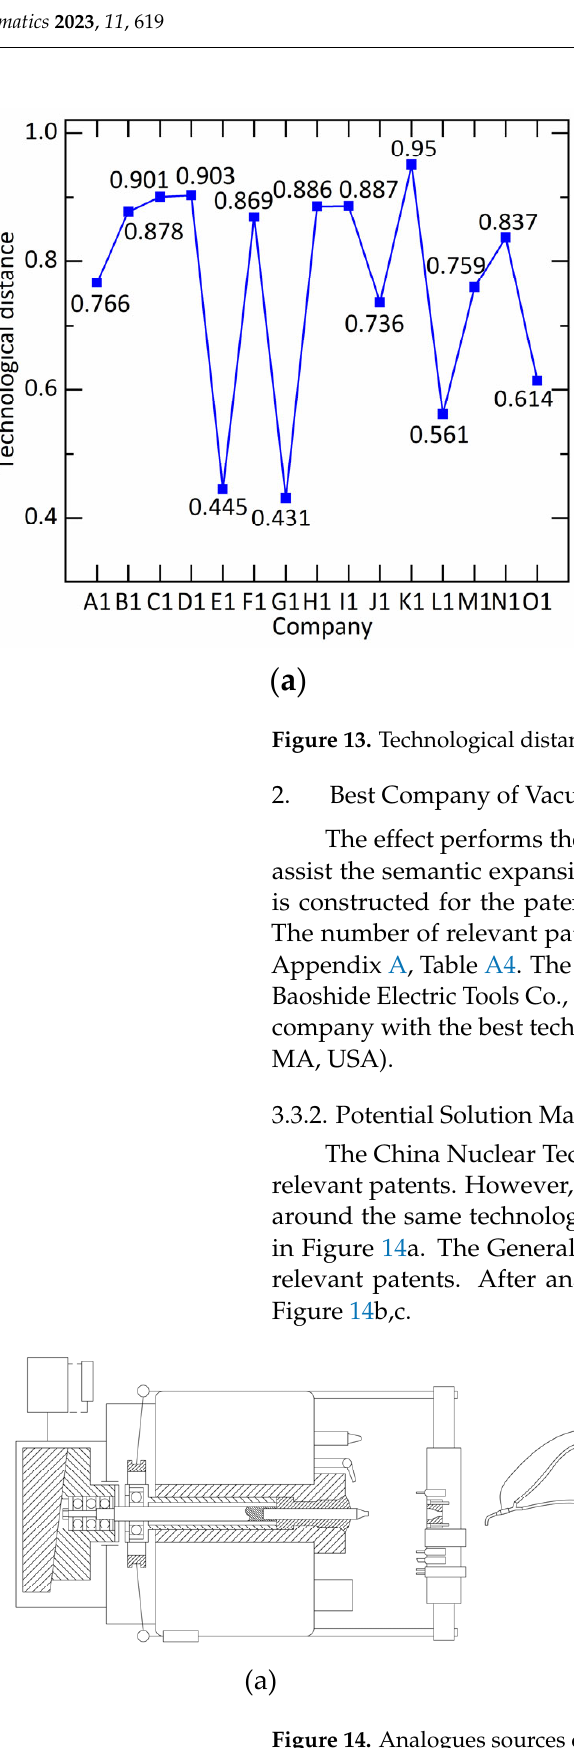
Figure 14. Analogues sources of potential technologies: ( a ) Steel pipe outer taper ‐ processing equip ‐ ment; ( b ) ventilator; ( c ) cryogenic fuel system for aircraft.